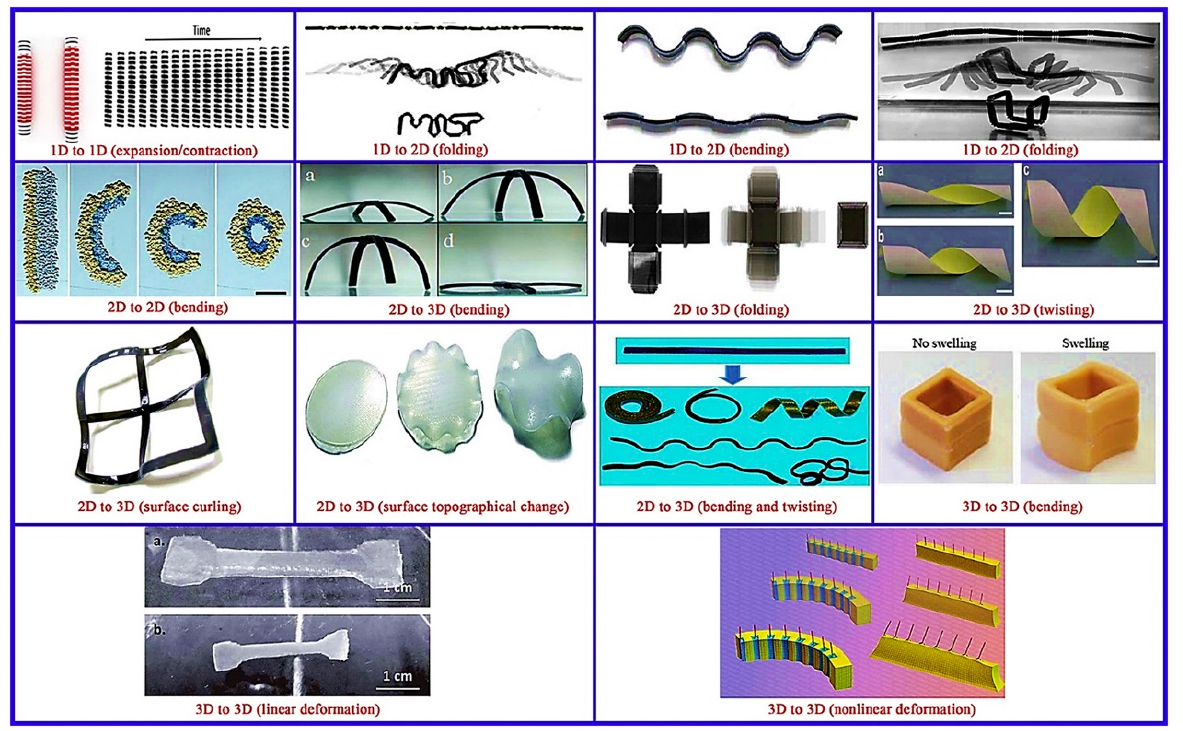
Figure 3. Various examples of different kinds of shape responses 1D to 1D (expansion and contrac-